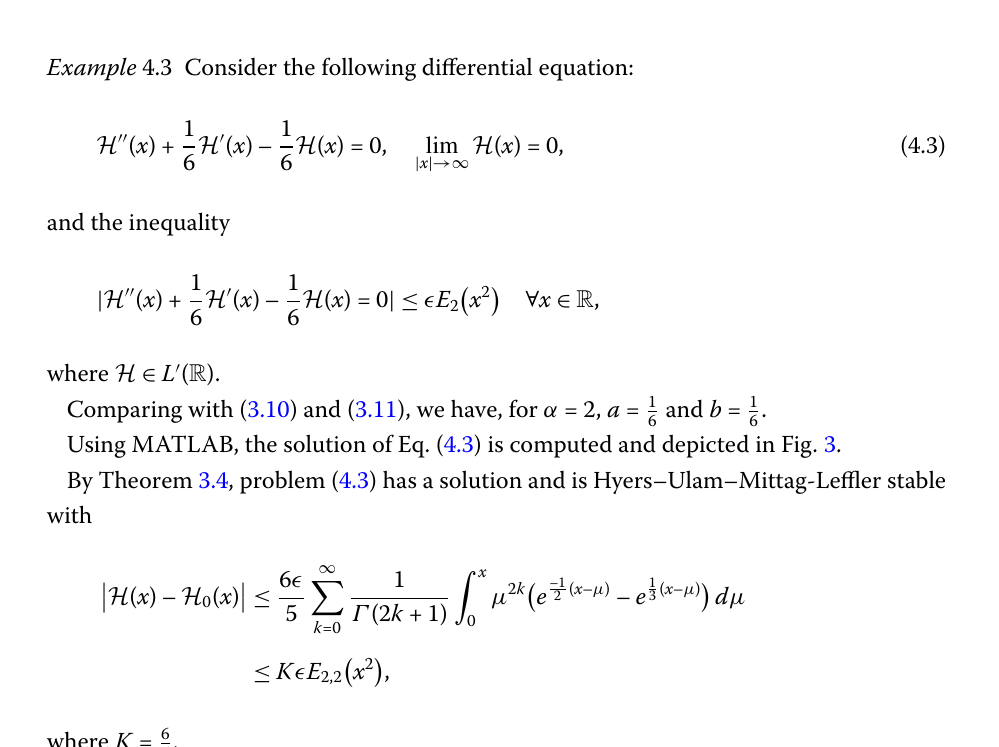
Figure 3 The solution of